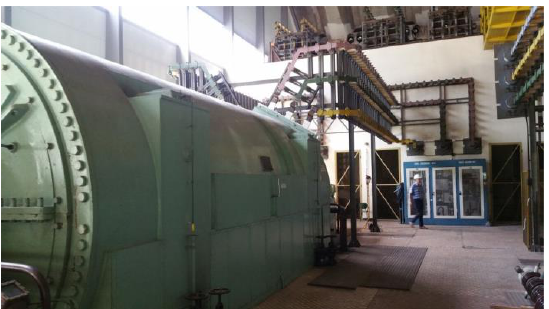
Figure 4. 2500 MVA short-circuit generator in Switchgear and Controlgear Testing Laboratory of Electrotechnical Institute in Warsaw.